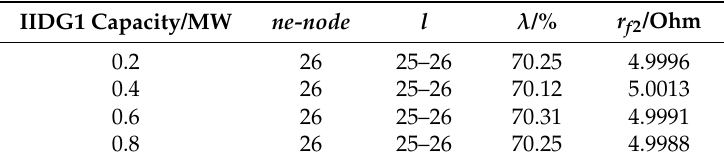
Table 14. Locating results of Strategy 1 with different capacities of IIDG1 for Case 5.